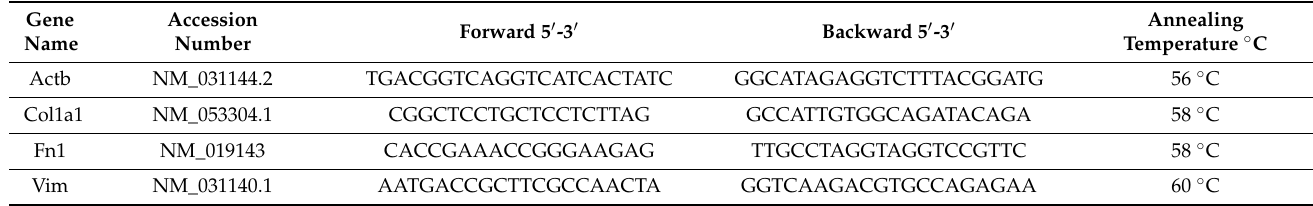
Table 2. Primer sequences and annealing